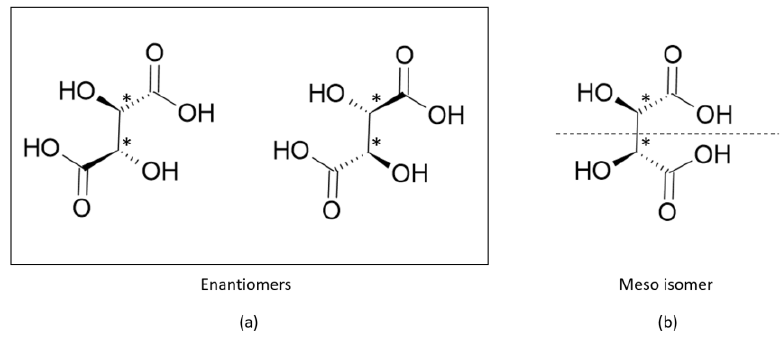
Figure 4. Tartaric acid presents ( a ) two enantiomers and ( b ) a meso isomer.